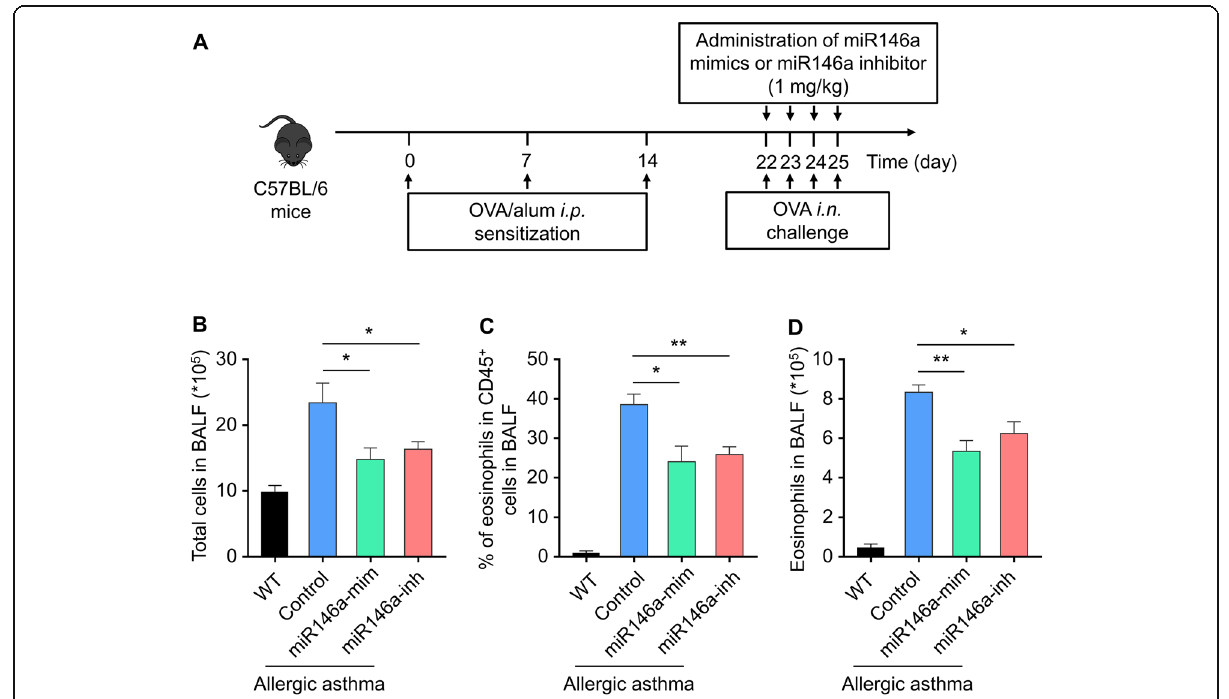
Fig. 1 Therapeutic efficacy of miR-146a mimics and miR-146a inhibitor against OVA-induced allergic asthma. a Schematic diagram of the experimental protocol. Twenty-four hours after the last challenge, cells collected from BALF were analyzed. b Total cells in BALF. c Percentage of eosinophils in CD45+ cells in BALF. (D) Eosinophils in BALF. Data represent means ± SD, n =6, * p <0.5; ** p <0.01, *** p